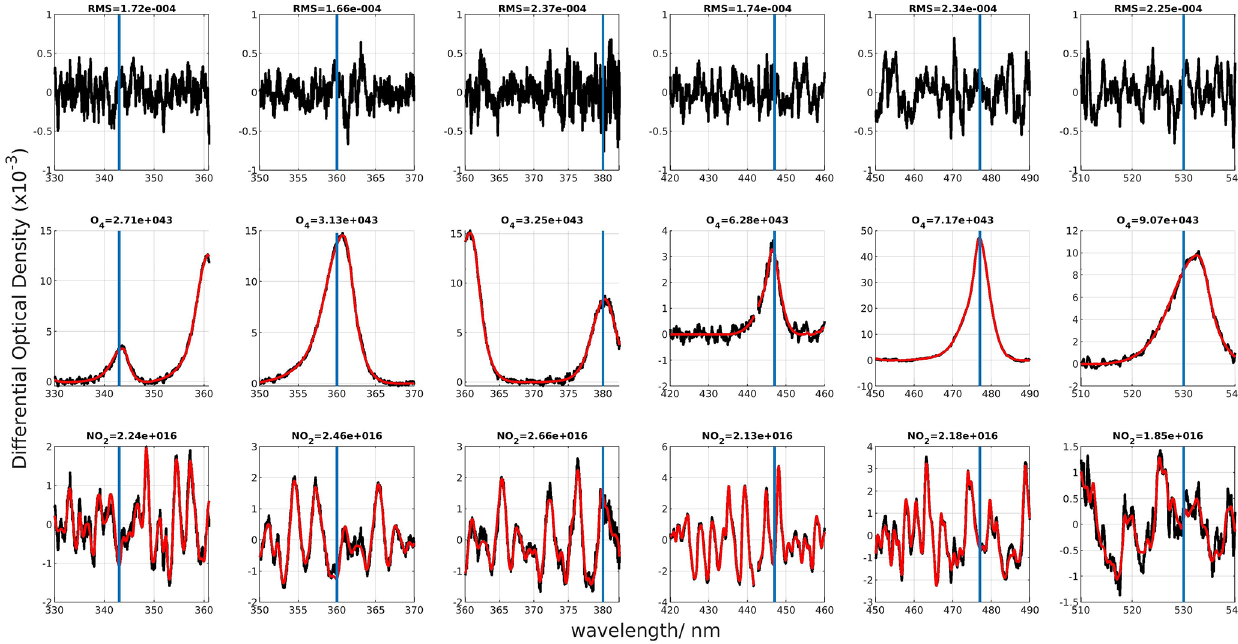
Figure 2. Results of the O 4 and NO 2 fit for the six selected fitting windows from the dual-scan MAX-DOAS measurements in Uccle (2 June 2019 at 07:05UTC). The measured spectra are represented with black lines, while the fit results are shown with red lines. The blue lines represent the six reference wavelengths. Table 1. TROPOMI NO 2 processor versions used in the present